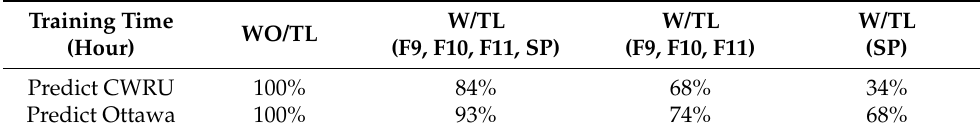
Table 4. Training time reduction in percentage (Unit: %).